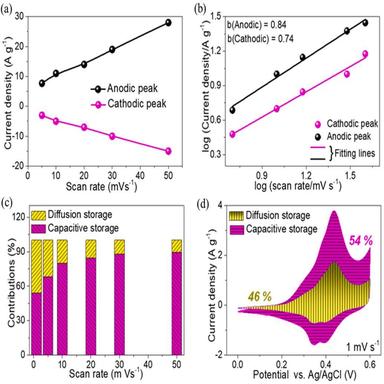
(a) Current density as a function of scan rate, (b) log (current density) versus log (scan rate), (c) percentage contributions as a function of scan rate, and (d) CV curve with percentage capacitive and diffusion charge storage.